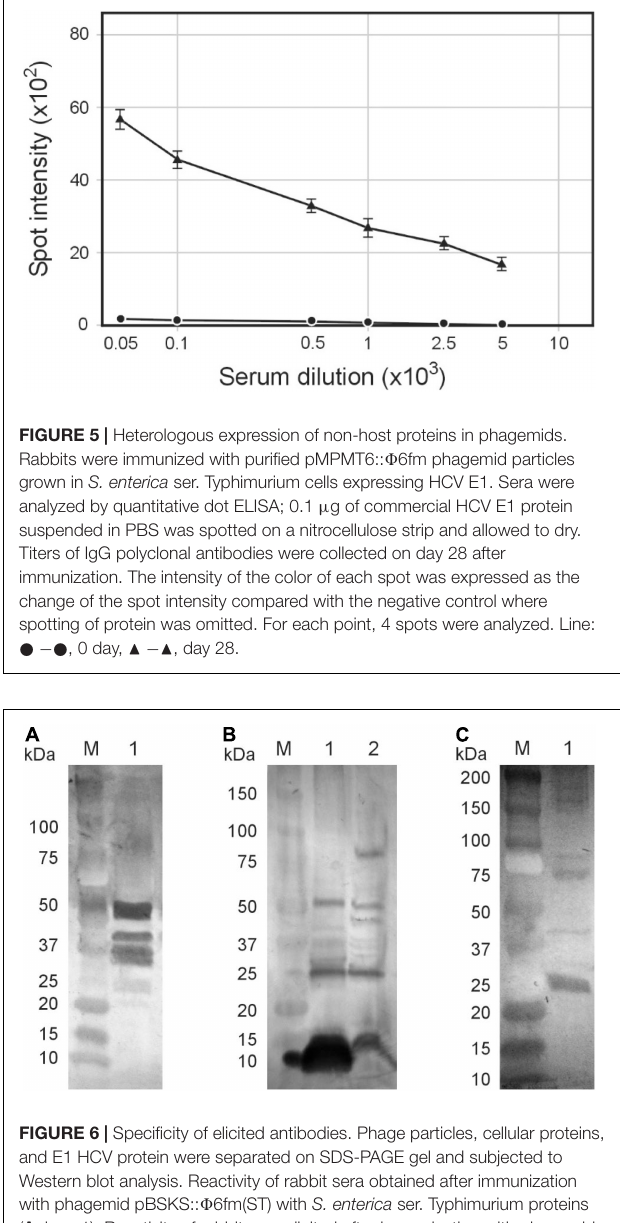
when probed against S. enterica ser. Typhimurium cells without phagemids. The outer membrane protein P2 is a predominant host protein associated with pBS:: (cid:56) 6fm(Hin) phagemid particles (Piekarowicz et al., 2020). Western blotting demonstrated that the phagemid isolated from pBS:: (cid:56) 6fm(Hin) generated antibodies against both phagemid proteins and several host proteins, one with a mobility similar in mass to the P2 protein